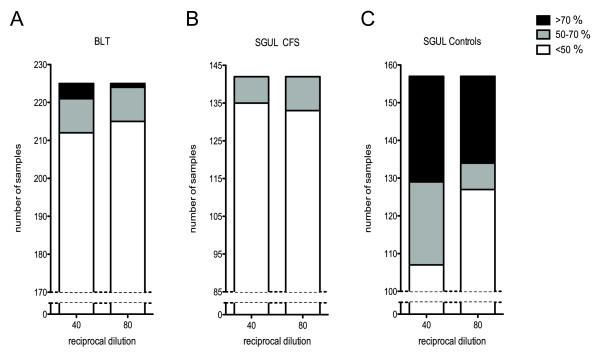
Distribution of neutralisation activity in three samples sets. Numbers of patients showing different degrees (>70% , 50-70% and <50%) of neutralisation of XMRV infectivity are shown for the 1/40 and 1/80 serum dilutions. A, Total BLT cohort (n = 226); B, SGUL CFS cohort (n = 142); C, SGUL control blood donor cohort (n = 157).